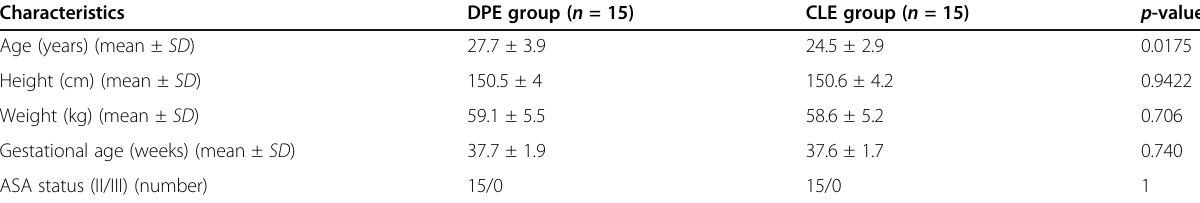
Table 1 Comparison of demographic variables between the study groups Characteristics